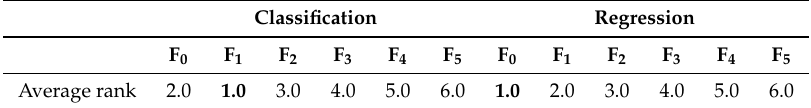
Table 15. Overall rankings of feature sets for different classification and regression